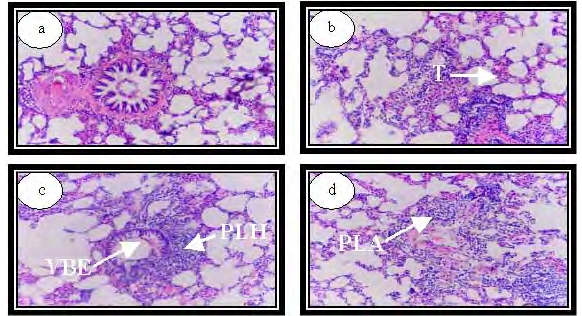
Figure 7 : Histopathology of kidney from female rats treated with saline (a) showing normal renal tissue structures; AcAaIT (b) showing mild dilation and hyperemia (MDH) of glomerular capillaries; AcMNPV (c) showing congested (C) renal blood vessels and hypercellularly (H) of some glomeruli; and SlNPV (d) showing congested glomeruli and interregnal capillaries (CGIC) (H&E x300).